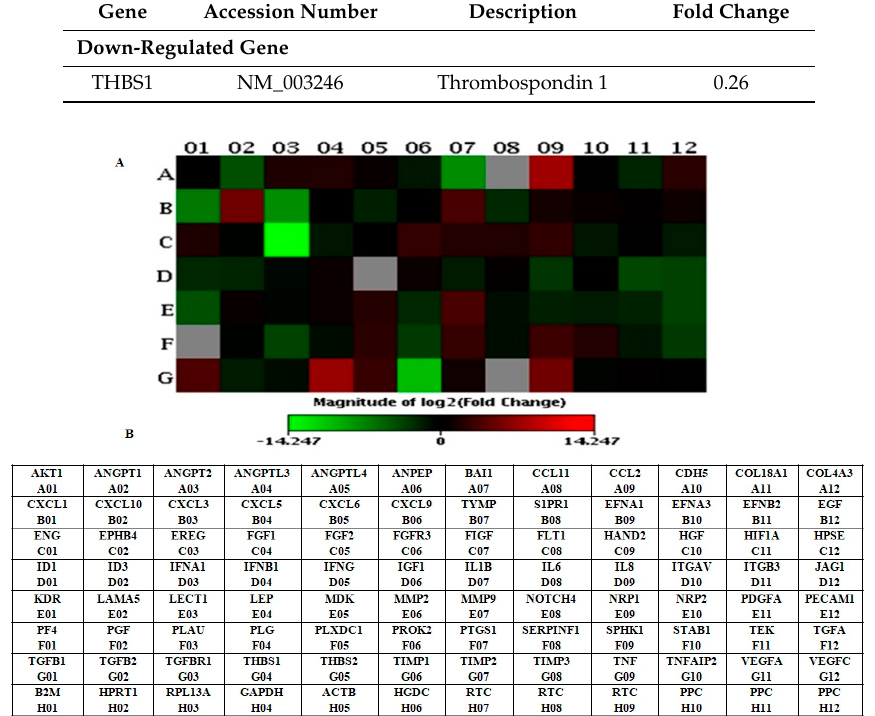
Table 3. Analysis of gene expression in LNCaP-MST cells after Nutlin-3 treatment using PCR array.